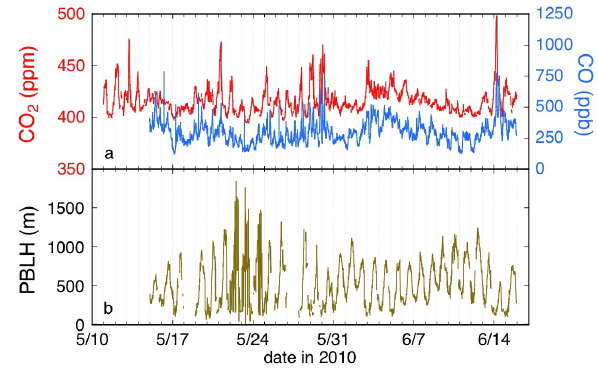
f02 Fig. 2. Time series for the CalNex-LA period for (a) CO and (b) planetary boundary layer height (PBLH). Measurements plotted are 10 min averages for CO 2 and CO and 15 min averages for